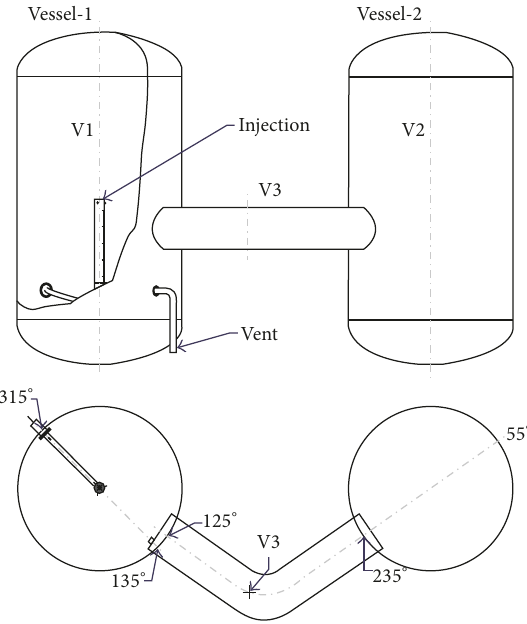
Figure 7: PANDA facility configuration for the SETH three-gas mixtures test